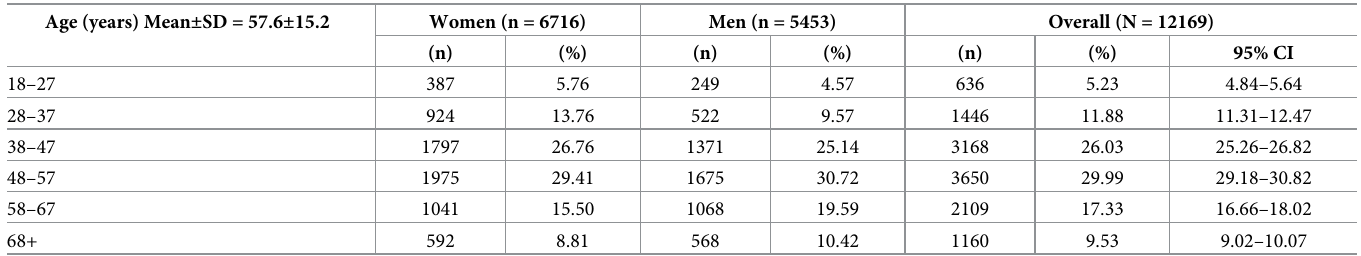
Table 1. Demographic characteristics. Age (years) Mean ± SD = 57.6 ±